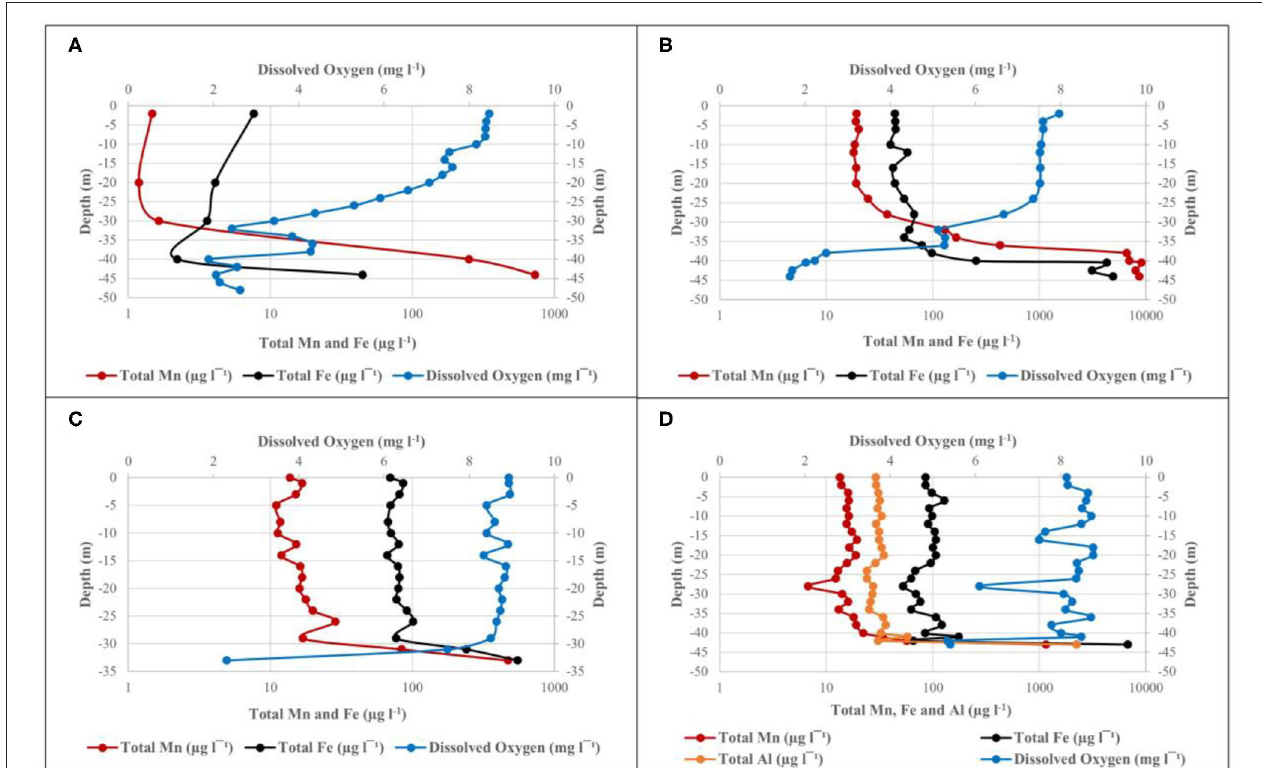
FIGURE 3 | Depth profile of DO, total Mn, and Fe at site 1 in the Blyderiver dam on (A) October 2015; (B) May 2016; (C) October 2016; and (D) February 2017. Aluminum analyses are also included in (D)